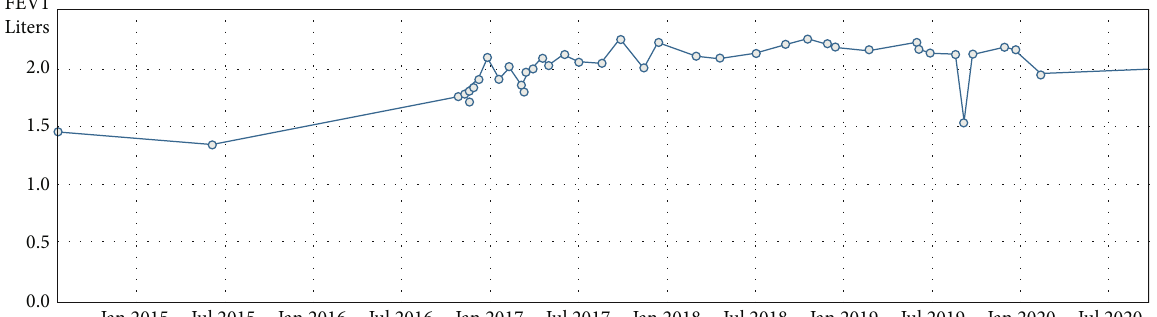
Figure 4: Graph of our patient ’ s FEV1 trend from pretransplant in June 2015 to posttransplant up to July 2020.